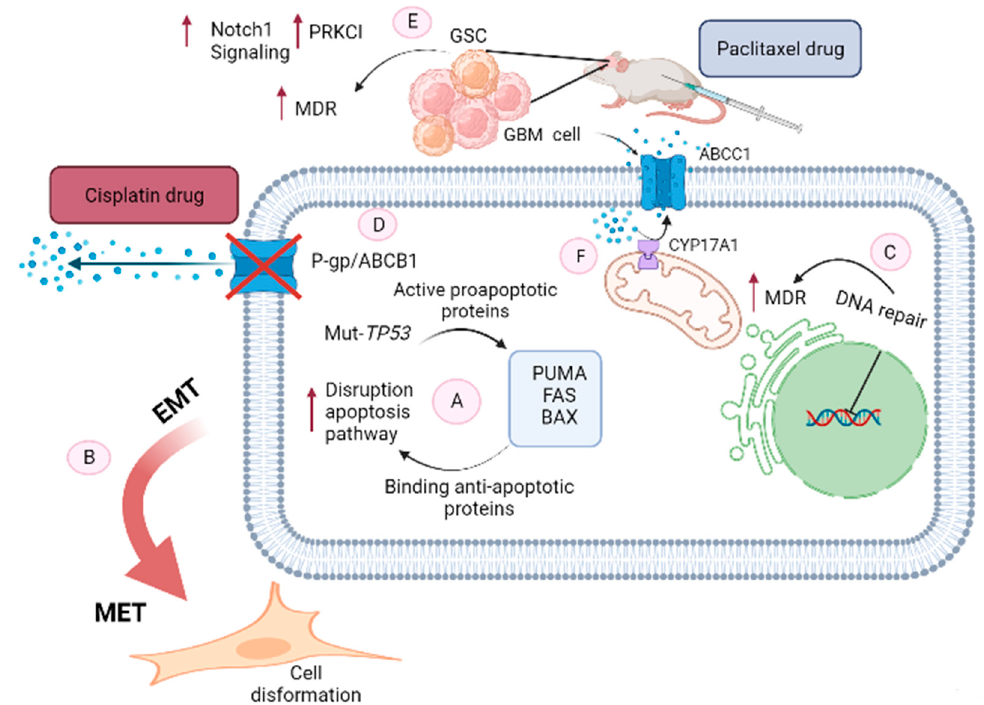
Figure 1. Mechanisms of MDR development in glioblastoma. A. Mutant TP53 ; the two accepted pathways leading to TP53 -mediated apoptosis are exogenous and endogenous. In endogenous apoptosis, TP53 activates pro-apoptotic proteins PUMA, FAS, and BAX. In response to activation of these proteins, TP53 binds to apoptotic proteins from the Bcl -2 family and finally induces cytochrome c/Apaf-1-dependent endogenous apoptosis. In contrast, mutations in the TP53 gene in cancers such as glioblastoma can cause PUMA, FAS, and BAX proteins to bind to anti-apoptotic proteins and result in the development of MDR. B. EMT; EMT is a subprocess that occurs during the progression of cancer which alters the morphology of cancer cells into highly motile and elongated mesenchymal-like cells which increases the capacity of tumor cells to resist chemotherapy. C. DNA repair; many chemotherapeutic drugs damage DNA in a manner that causes cell cycle arrest and cell death. Therefore, DNA repair involves an intricate network of repairing the cell, and that process leads to the development of MDR. D. P-gp /ABCB1 as a transmembrane protein causing lowered drug accumulation inside cells and consequently diminished drug efficacy. E. In glioblastoma stem-like cells (GSC), Notch1 and PRKCI are overexpressed and are associated with MDR. F. CYP (17A1) as a drug metabolizer overexpressed in glioblastoma and efflux the chemotropic drug through ABCC1 transporter.